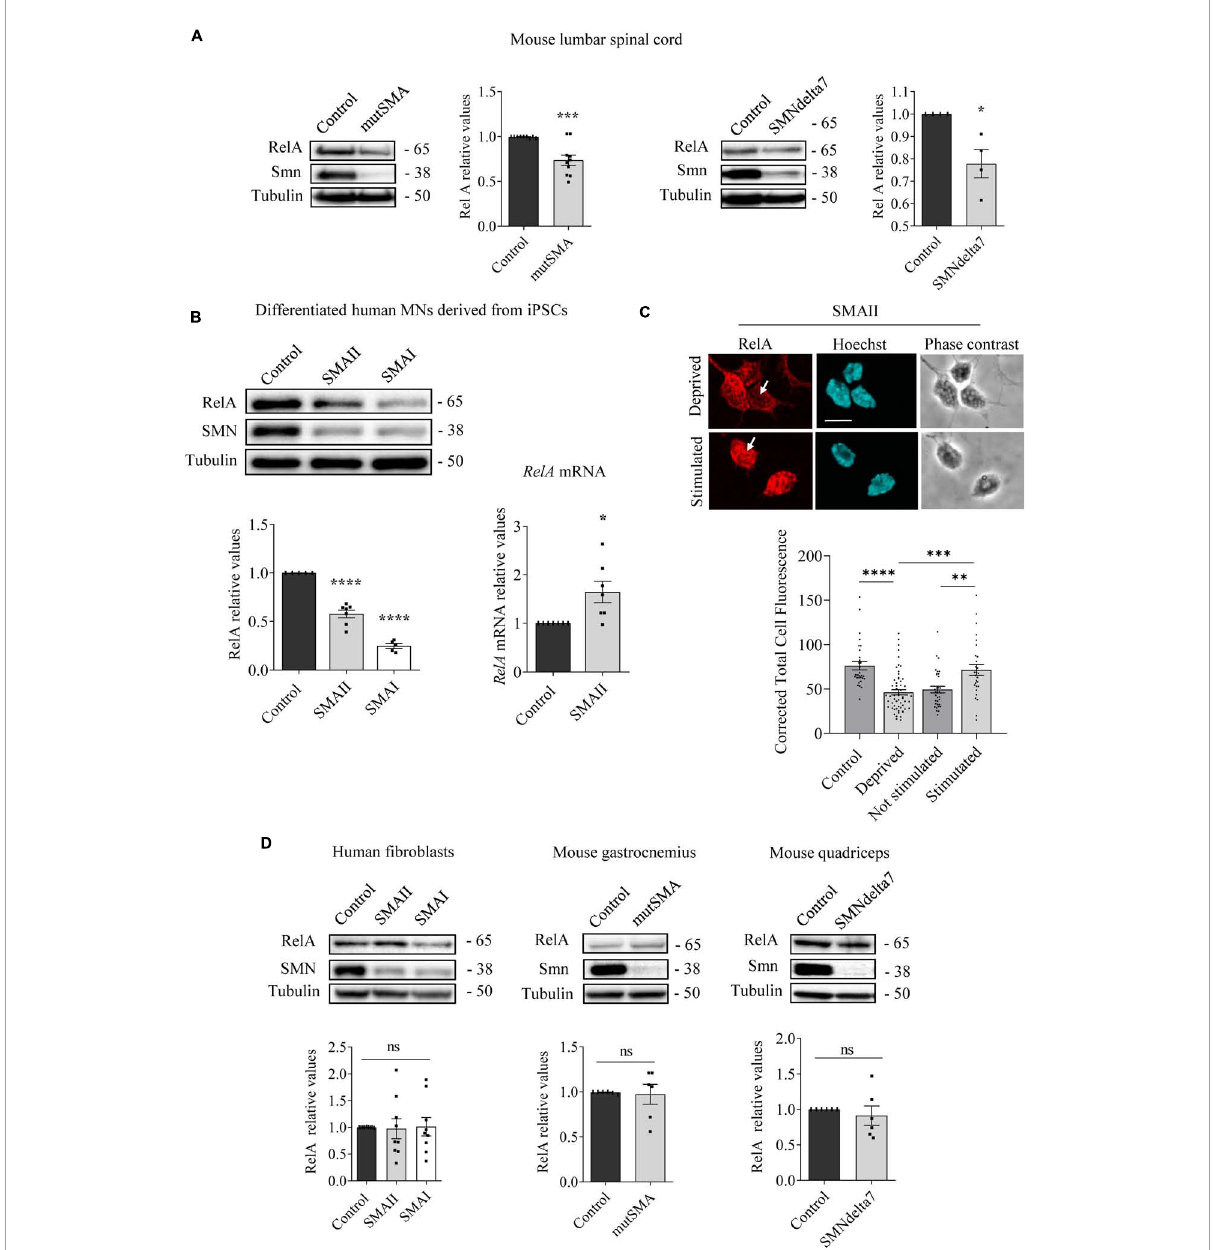
FIGURE2 Changes of RelA protein level in spinal muscular atrophy (SMA) models. Western blot using anti-RelA and anti-SMN antibodies was used to analyze protein extracts of P2 control and mutSMA and P5 control and SMNdelta7 spinal cords (A) ; 7 days differentiated control, SMAII, and SMAI human MNs (B) (left); 48 h cultured control, SMAII and SMAI human fibroblasts (D) (left); P2 control and mutSMA gastrocnemius and P5 control and SMNdelta7 quadriceps (D) (middle and right). Membranes were reprobed using anti- α -tubulin antibody. Graph values represent the expression of RelA versus α -tubulin and correspond to the quantification of at least four independent experiments ± SEM. (B) (right) Total RNA was extracted from 7 days differentiated control and SMAII human motoneurons (MNs) and reverse transcribed to cDNA. Gapdh gene was used as control. Graph values are the mean of RelA gene expression from three independent experiments ± SEM. (C) Seven days differentiated SMAII human MNs were cultured 24 h in the presence (control) or absence (deprived) of IGF and CNTF. Twenty-four hours later, cells were stimulated 5 min with medium containing (stimulated +) or not (stimulated –) 20 ng/ml IGF and 20 ng/ml CNTF. Cultures were fixed and processed for immunofluorescence using an anti-RelA antibody. Representative immunofluorescence confocal images of SMAII human MNs using an anti-RelA (red) antibody. Hoechst staining (blue) was used to identify MN nucleus. Graphs represent the mean of relative RelA fluorescence measured in MN nucleus, corresponding to the quantification of at least 30–40 cells per condition from three independent experiments ± SEM. Scale bar, 15 µ m. Arrows indicate nuclear localization of RelA. Asterisks indicate significant differences using Student t -test (A,B,D) or one-way Anova with Dunnett’s or Tukey’s multiple comparisons post-test (C,D) ( ∗ p < 0.05; ∗∗ p < 0.005; ∗∗∗ p < 0.0005; ∗∗∗∗ p < 0.0001; ns, no significant differences p >